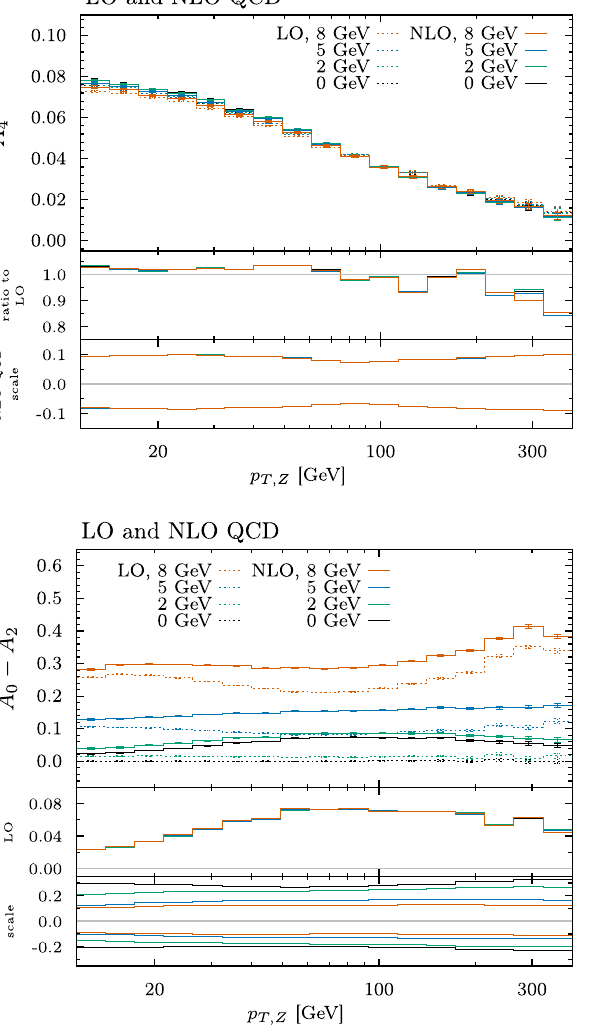
The four (left) and three (right) different curves indicate the result with different values of the single lepton p T cut. See text for more